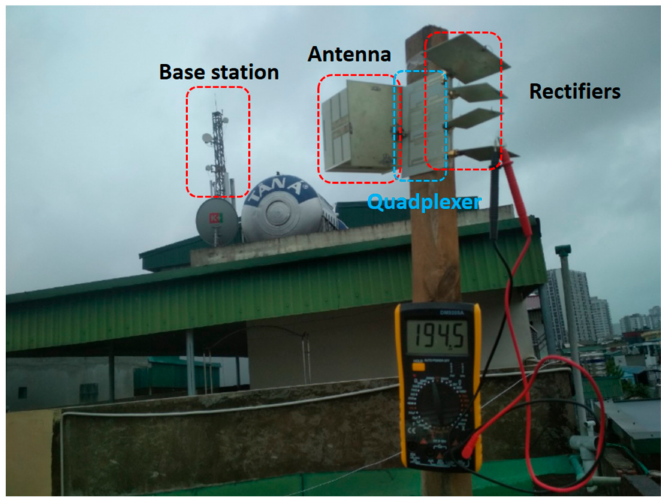
Figure 14. Experimentation of the proposed multiband rectenna.